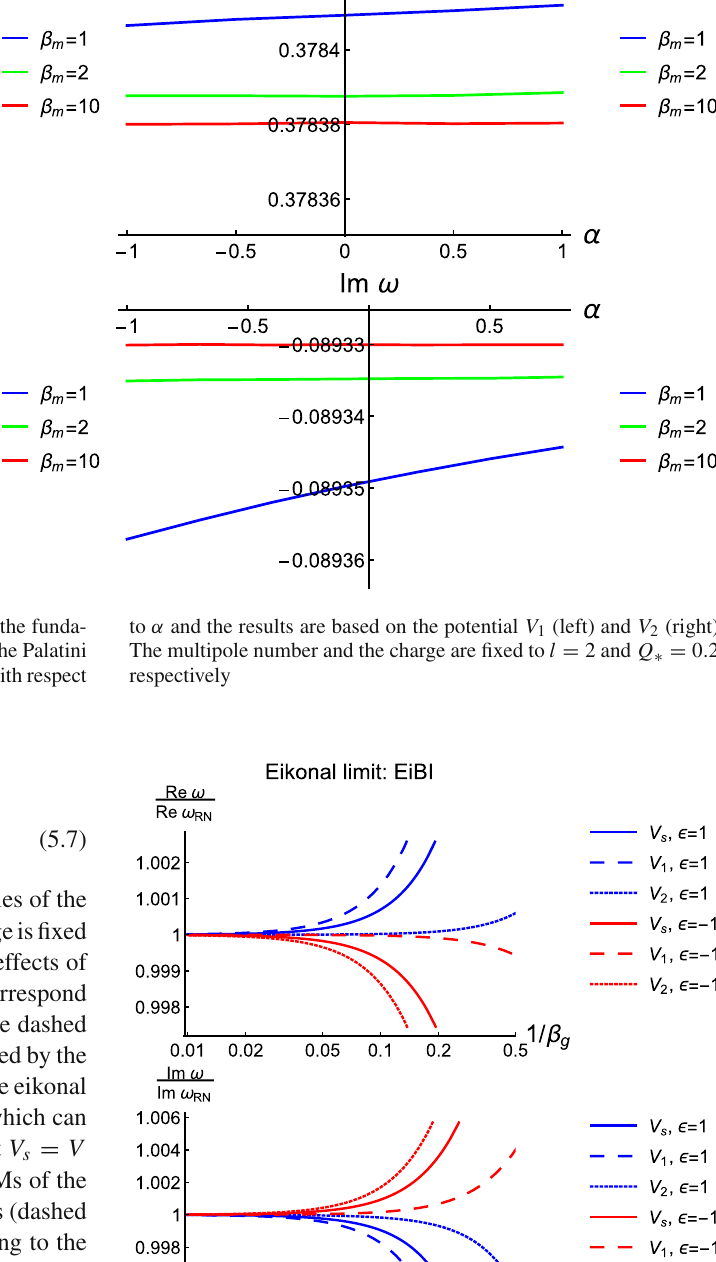
Fig. 4 The real part (upper) and imaginary part (lower) of the QNMs of the EiBI charged black holes in the eikonal limit ( l → ∞ ) are shown with respect to 1 /β g . The solid curves are included as well, indicating theQNMsofthemasslessscalarfieldperturbationswhicharedescribed by the potential V s = V given in Eq.